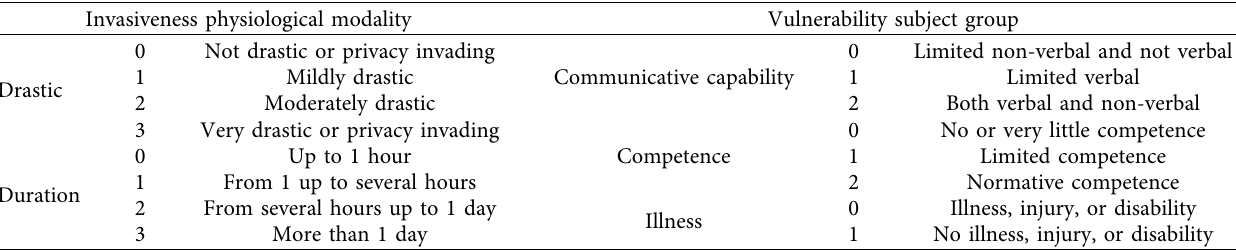
Table 2: Scoring for invasiveness of modalities and vulnerability of subject